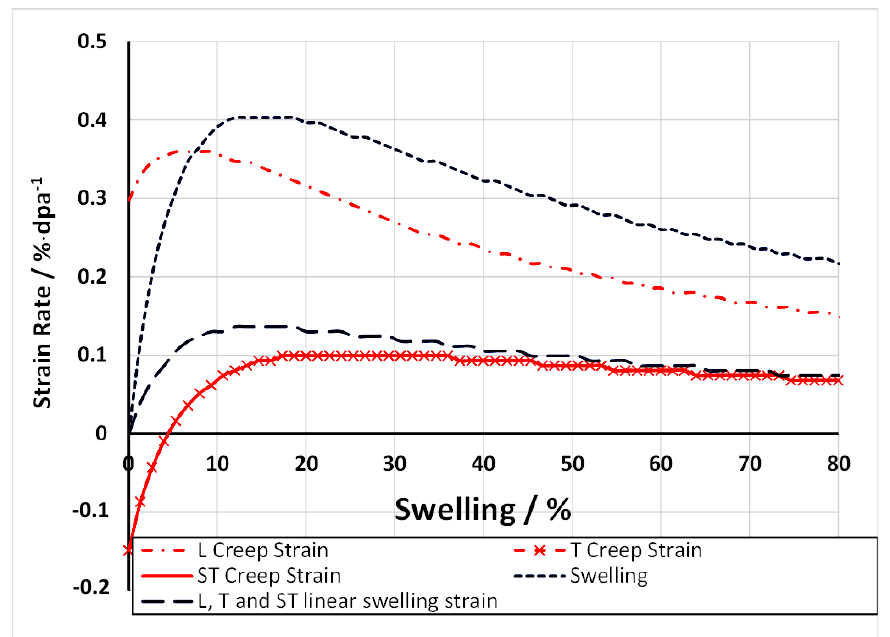
Figure 32. Uniaxial creep (L direction) and swelling for a dislocation density of 10 15 m −2 s = 0.15, p = 0.3. L, T and ST refer to the longitudinal, transverse and short-transverse directions of a typical tensile specimen.